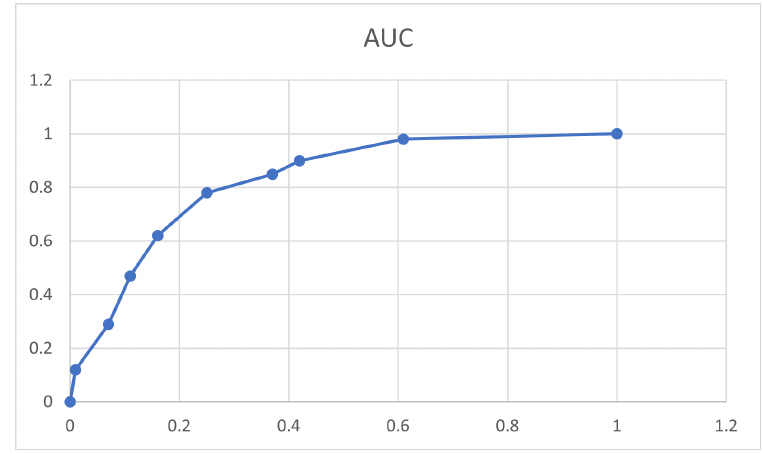
Figure 5. Area under the curve comparison for several detection